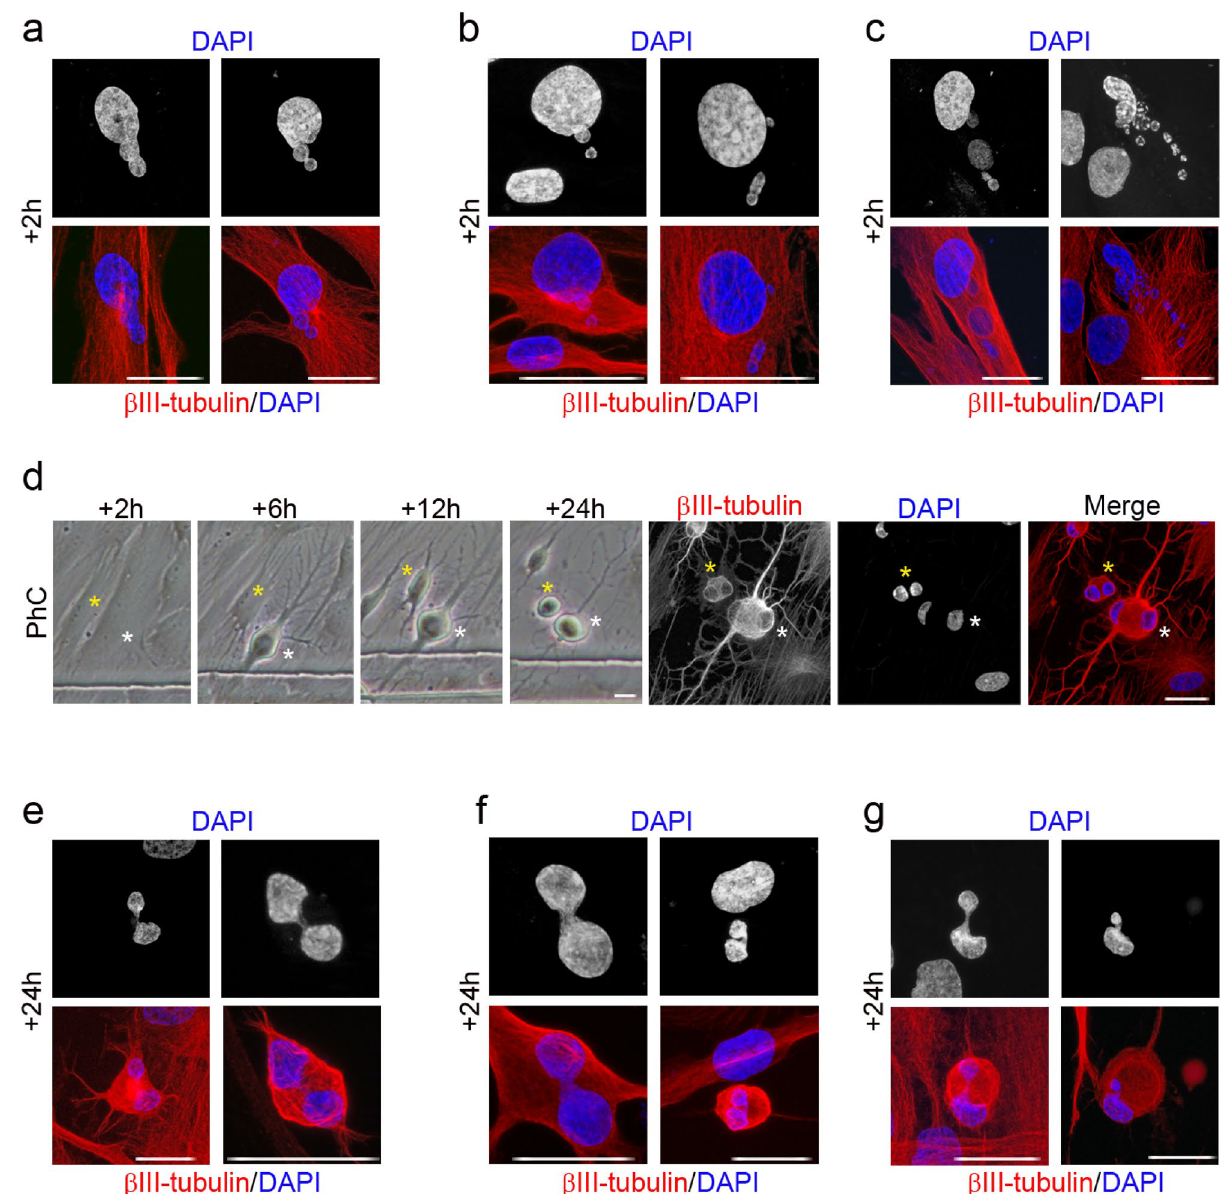
Figure 8. Nuclear shape remodelling occurs during neurogenesis from hDPSCs. DNA-containing structures arose from the main nuclei ( a ) and started to move ( b ) towards specific positions within the cell ( c ) and temporarily formed lobed nuclei ( d ). These lobed nuclei then connected together through small DNA- containing structures to form nucleoplasmic bridges ( e ). Finally, the lobed nuclei connected by internuclear bridges ( f ) joined to form single nuclei with an eccentric position within hPDLSC-derived neuron-like cells ( g ). Scale bar: 25 μm. PhC: Phase-contrast